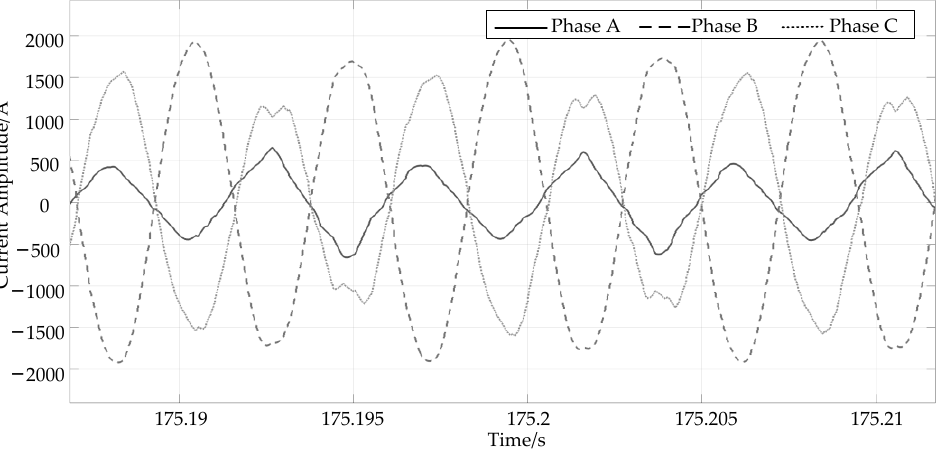
Figure 25. Stator current in the case of phase-to-phase short-circuit fault. Similarly, observing the impact of the phase-to-phase short circuit on the grid-side current in Figure 26, it can be seen that the grid side is also impacted by the short circuit, and the current amplitude of the grid is greater after stabilization.